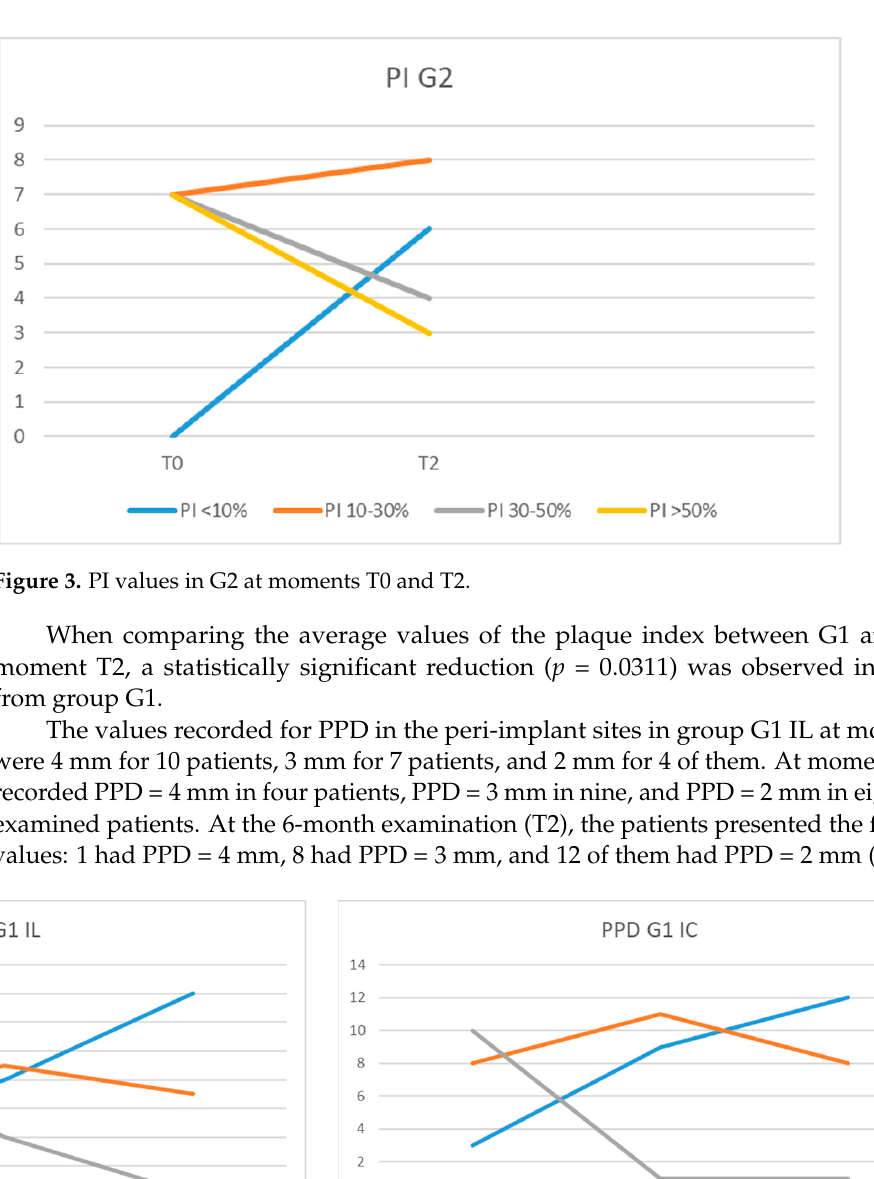
Figure 4. PPD values in G1 IL and G1 IC at moments T0, T1, and T2. In G2, we recorded at the initial examination (T0) PPD = 4 mm in 10 of the examined patients, PPD = 3 mm in 9, and PPD = 2 mm in 2 of them (Figure 5). The mean probing pocket depth (PPD) in the G1 IL group was 3.28 mm at T0, 2.80 mm at T1, and 2.33 mm at T2. For G1 IC, the values recorded for PPD were 3.33 mm (T0), 2.85 mm (T1), and 2.61 mm (T2). For G2, the average PPD values were 3.38 mm at T0 time and 3.23 mm at T2